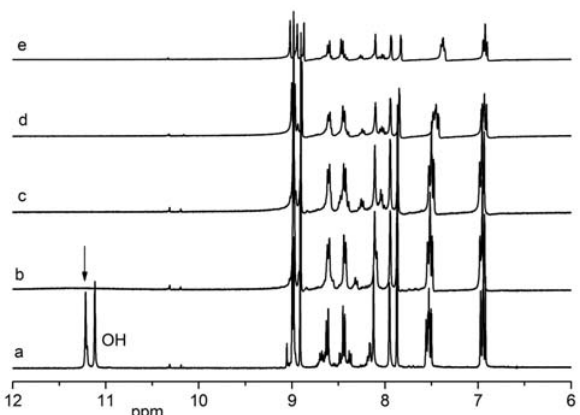
Fig. 7. Portion of 1 H NMR spectra of compound 2 (0.02 mol · L –1 ) in DMSO- d in the presence of increasing amount of AcO – : a) free 6 1 ; b) 1 + 0.5 equiv.; c) 1 + 1.0 equiv.; d) 1 +2.0 equiv.; e) 1 + 5.0 equiv. of [ (n-Bu) N ] 4